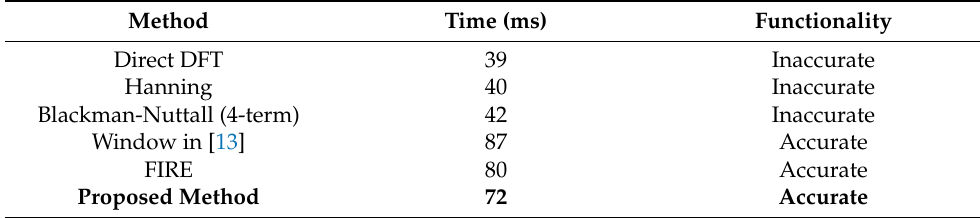
Table 1. Computation time and functionality comparison. ( J = 3413.33, M = 32,768, 16-b